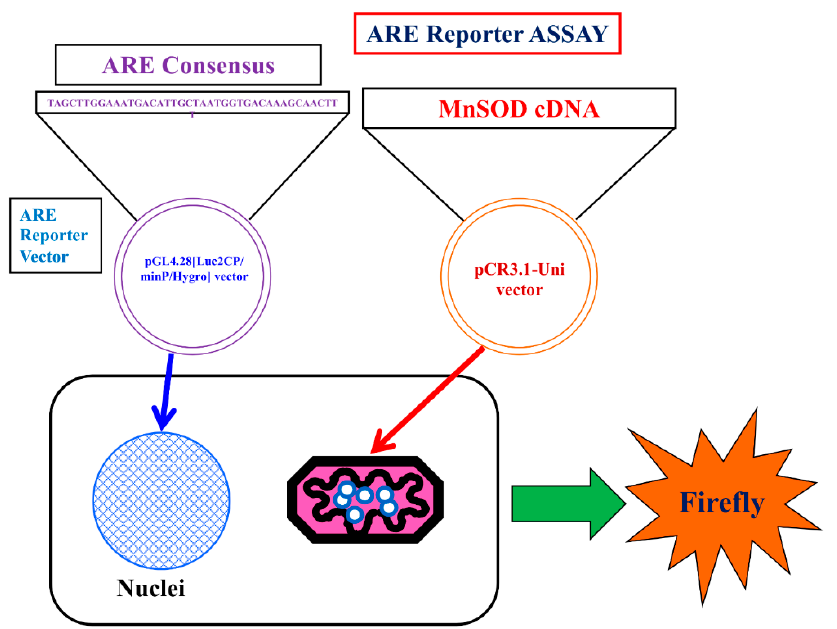
Figure 7. Schema of the Luciferase reporter assay for ARE. ARE consensus was stably transfected in the cells. hMnSOD vector is transiently transfected in the cells. Using this method, whether mtROS promote LAR II can be examined. In hMnSOD vector-transfected cells (MnSOD), if the fluorescence significantly decreased compared with that in vector-alone-transfected cells (Vector), these will suggest the amounts of mtROS became lower in MnSOD-transfected cells. As a results, ROS to bind keap1 will become less and the final amount of separated Keap1 to bind to ARE will became less. resulting less amount firefly luciferase activity (LAR II).